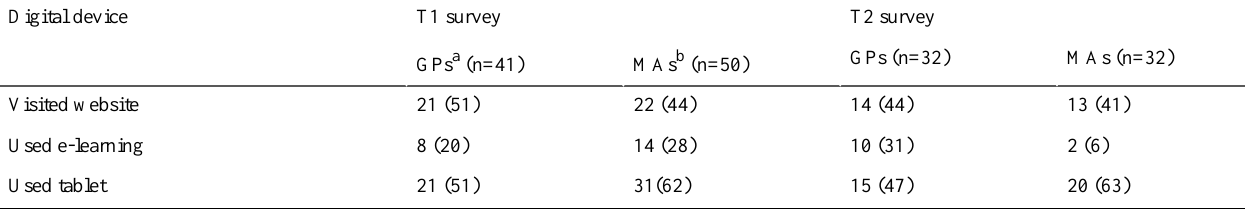
Table 3. Uptake of digital components in the intervention group of the study, n (%).